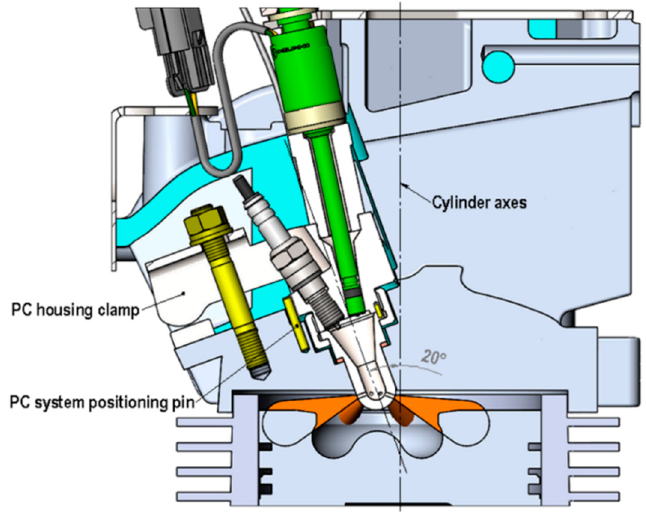
Figure 3. Pre-chamber position in cylinder head.